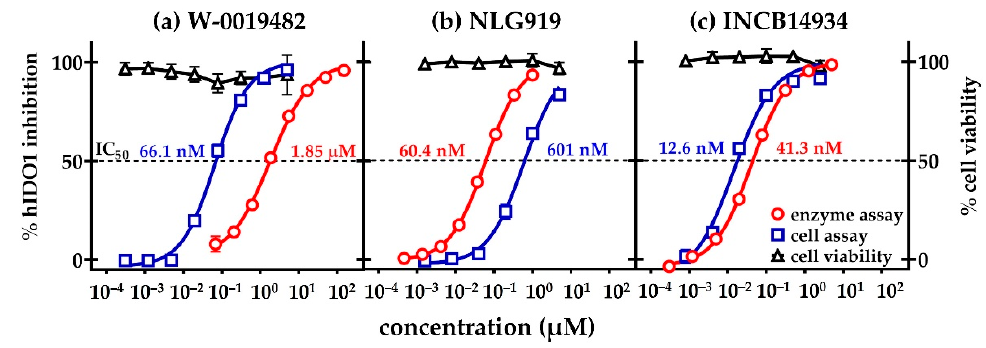
Figure 4. Cell viability (black triangles) and inhibition of hIDO1 activity measured using the LLTC- hIDO1 cell-based assay (blue squares) compared to that measured using an enzymatic assay (red circles) with increasing concentrations of ( a ) W-0019482, ( b ) NLG919 and ( c ) INCB14943.